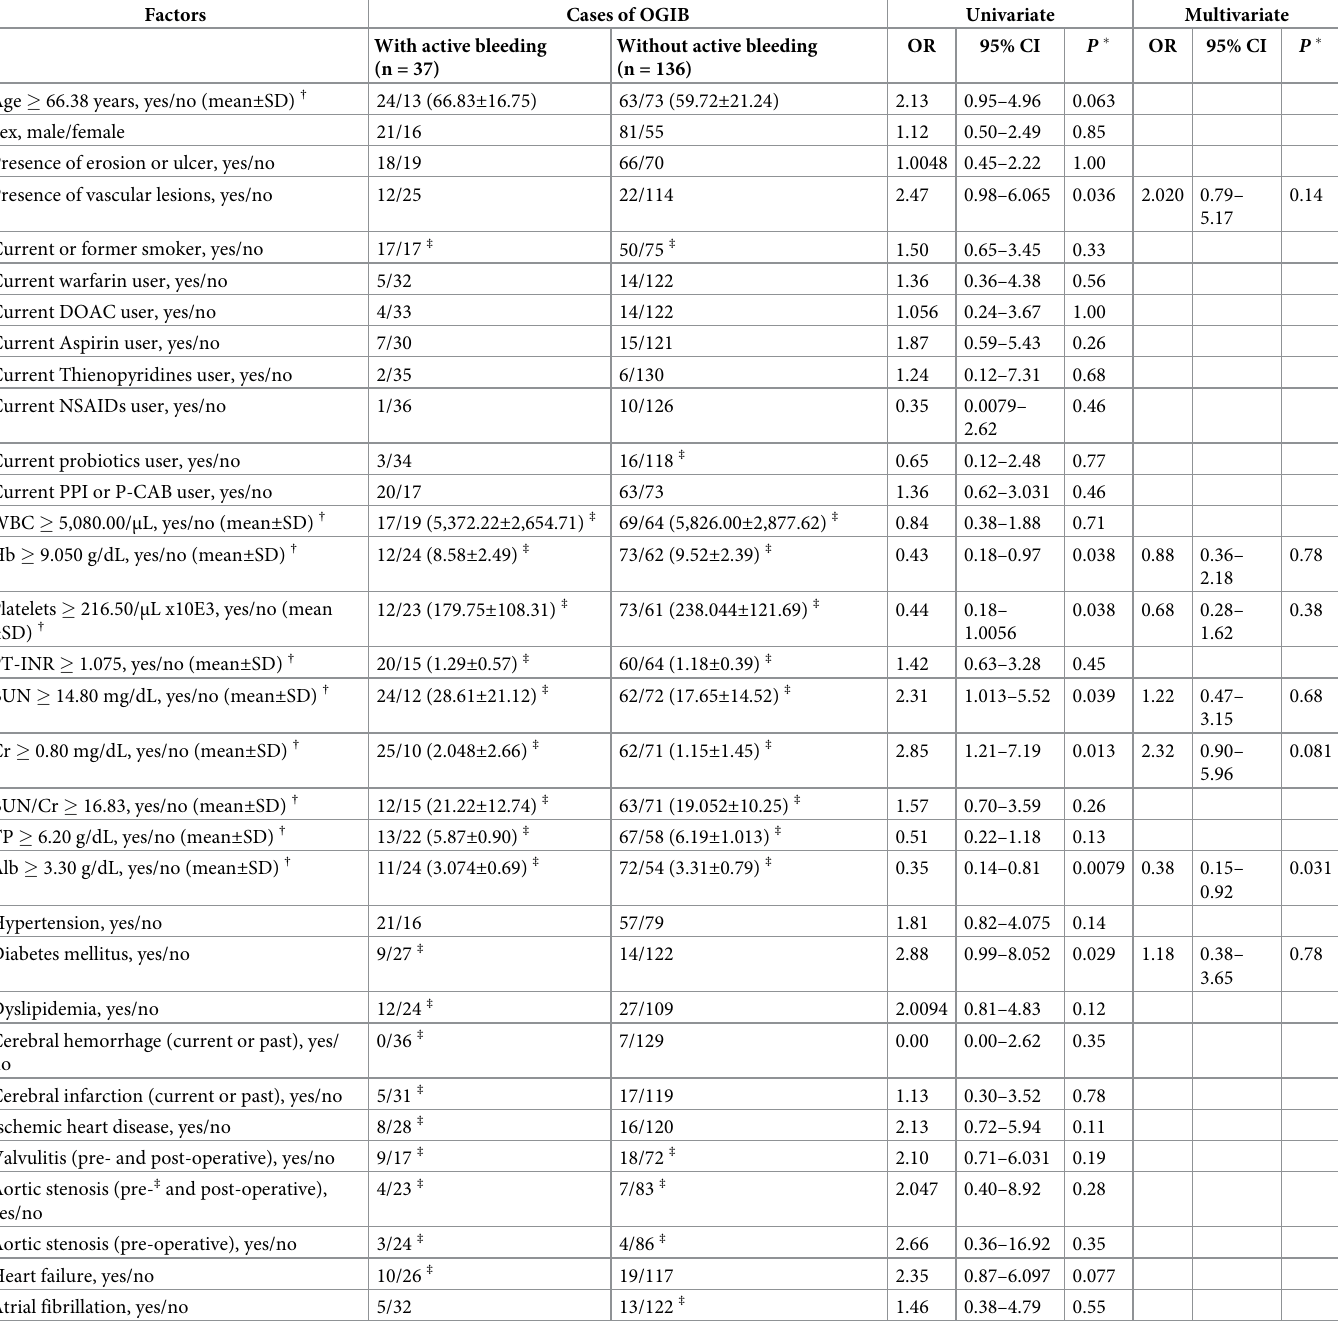
Table 3. Comparison of clinical features in cases of obscure gastrointestinal bleeding with and without active bleeding, identified by univariate and multivariate analysis.